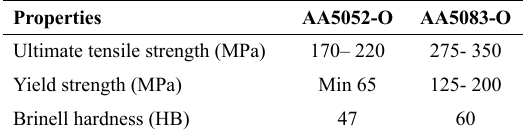
Table 2. Mechanical properties of AA5052-O and AA5083-O alloys 25 .